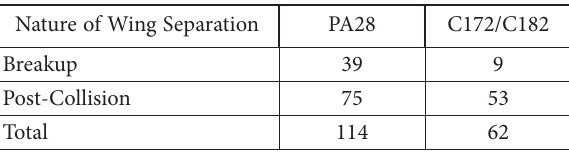
Table 1. Mid-air breakups vs. post-collision wing separations between PA28s and C172s/C182s Nature of Wing Separation